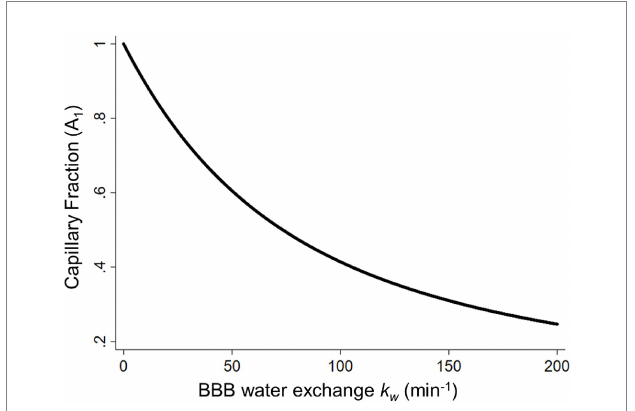
FIGURE 4 The capillary fraction of labeled water ( A 1 ) plotted as a function of the BBB water-exchange rate k w (min − 1 ). Simulated data was generated using the arterial transit time, the T1 of arterial blood (1.66 s) and gray matter (1.82 s), the labeling efficiency (85%), the brain–blood partition coefficient (0.9 ml/g), and the b values (0 and 50 s/mm 2 ) at a long post labeling delay (1.80 s) as inputs for the look-up table algorithm. BBB, blood–brain barrier [adapted with permission from Uchida et al. (2022a)].